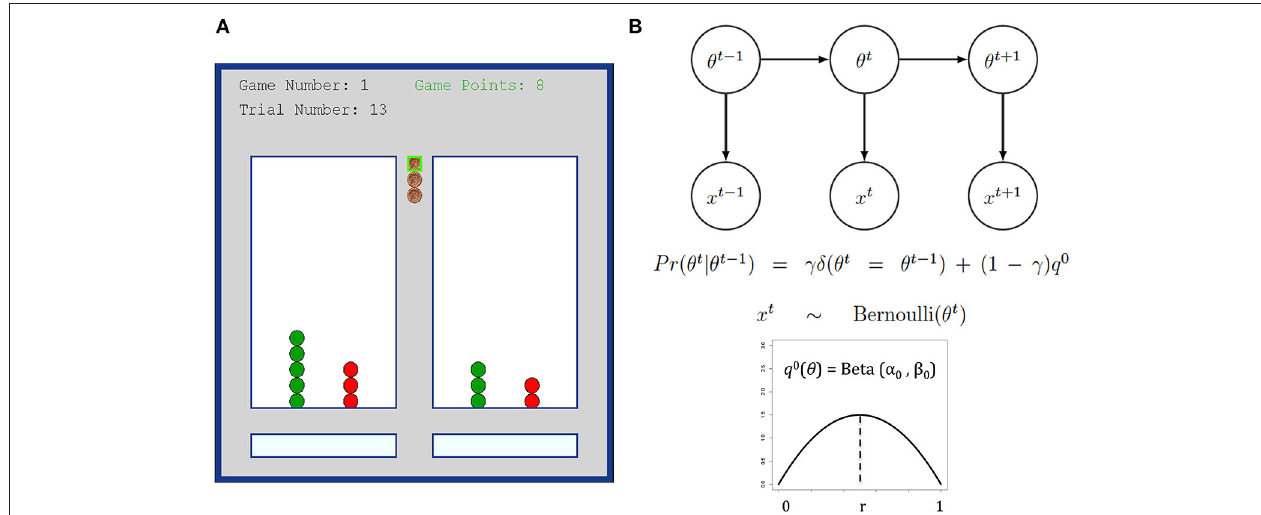
FIGURE 1 | (A) Bandit task interface snapshot. Participants completed 20 games, each with 16 trials. (B) DBM illustration and the generative equations. The reward rate of each arm are assumed to be independently drawn at the start of a game from a Beta distribution q 0 = Beta ( α 0 , β 0 ), fixed throughout the game, and with mean r = ( α 0 )/( α 0 + β 0 ) . DBM assumes that subjects believe that the reward rate θ for any arm can reset on any trial with probability 1- γ , otherwise it is the same value as the last trial.